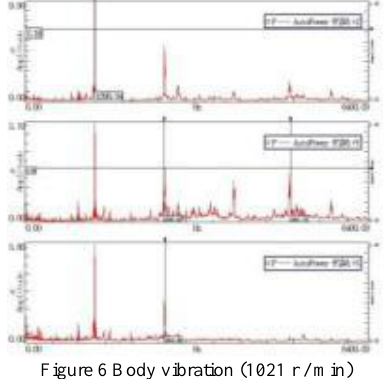
Figure 6 Body vibration (1021 r / min)